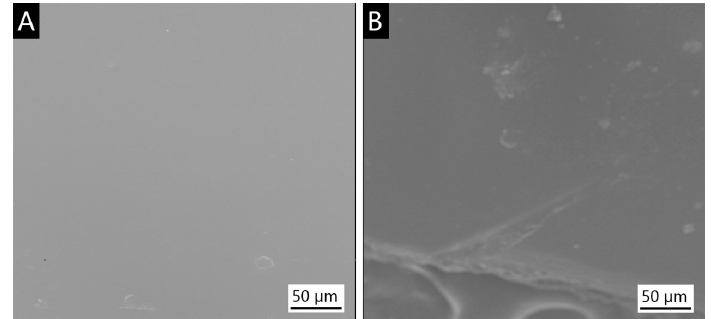
Figure 3. Scanning electron microscope (SEM) of WUVCW from sample 6 and sample 9: ( A ) 1.0% CaCO 3 and 2% talcum and ( B ) 1.0% CaCO 3 and 5% talcum.